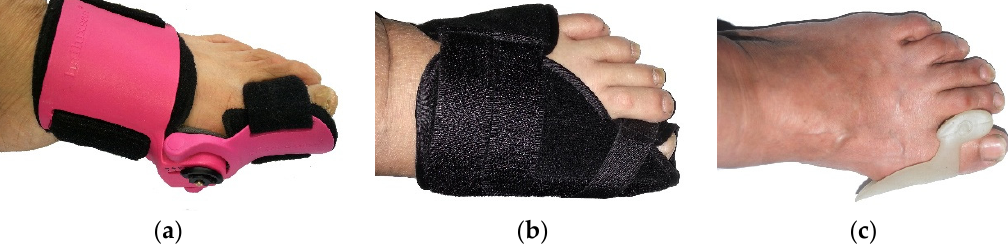
Figure 1. Three different types of orthotics used in the treatment trial. ( a ) Orthotic Type 1; ( b ) Orthotic Type 2; ( c ) Orthotic Type 3.